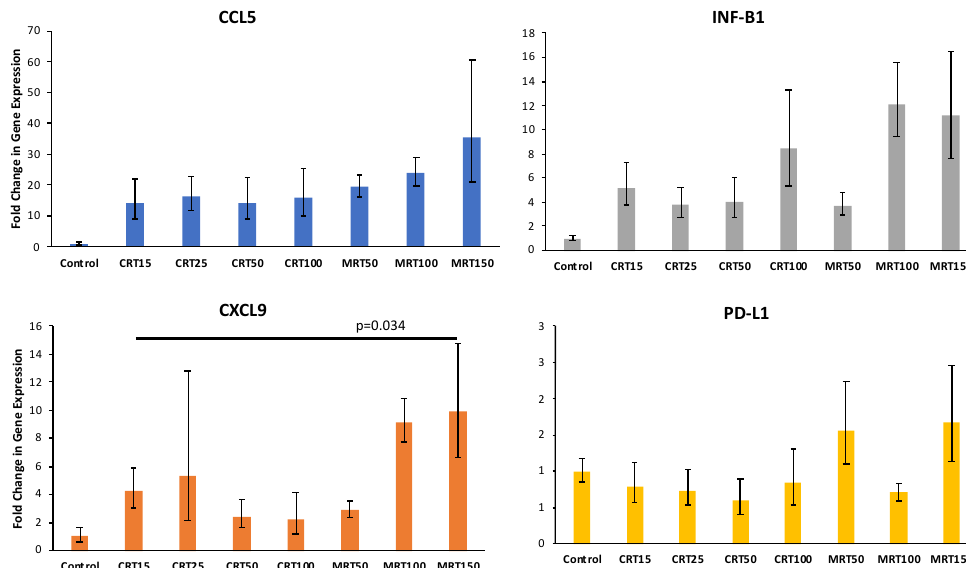
Figure 5. RT-qPCR analysis. The columns demonstrate the mean ± SE of fold change in gene expression in different treatment groups, evaluated using RT-qPCR. Reported p -value is calculated using t -test, comparing expression between MRT 150Gy and CRT 15Gy. MRT = microplanar radiation therapy; CRT = conventional radiation therapy.